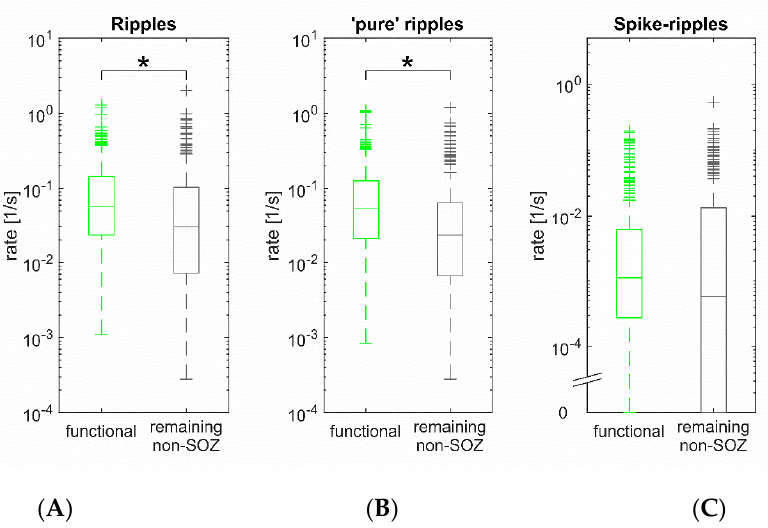
Figure 3. Eloquent cortex generates ‘pure’ ripples. ( A ) Ripple rate was higher ( p < 0.001) in eloquent cortex than in remaining non-SOZ channels. ( B ) This difference was due to the fact that eloquent cortex generates significantly more ‘pure’ ripples ( p < 0.001). ( C ) Spike-ripple rates, in contrast, were not significantly different ( p = 0.87).